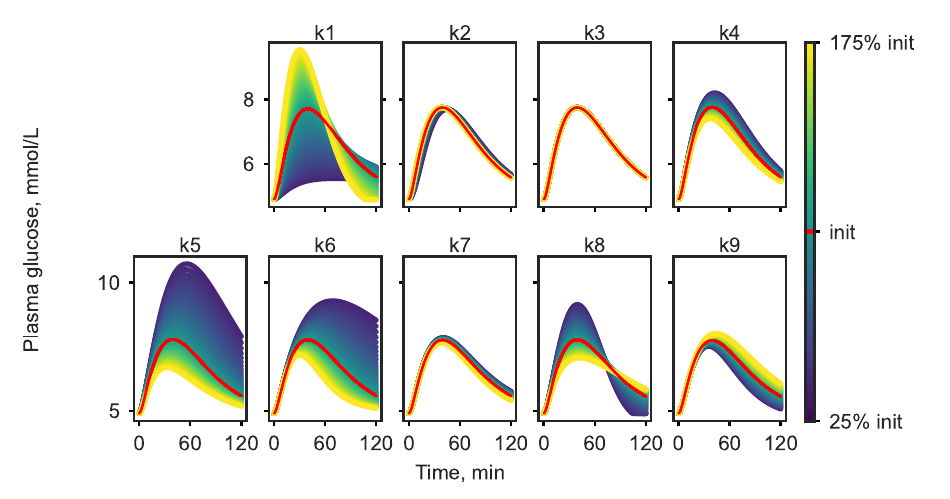
Fig 2. Local parameter sensitivity analysis demonstrated on simulated plasma glucose